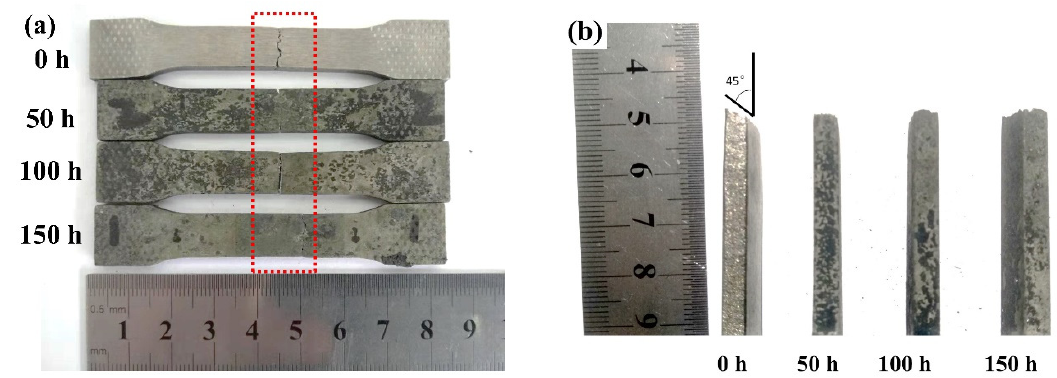
Figure 10. Photographs of the tensile-tested repaired Inconel 718 specimens with pre-hot corrosion testing in the molten salt at 650 °C: ( a ) failed specimens and ( b ) fracture surfaces.